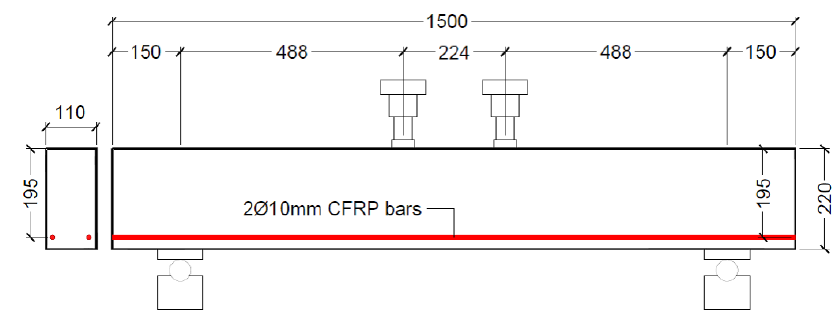
Figure 9. Validation test setup and beam dimensions. Table 5. Material properties of the validation specimen.